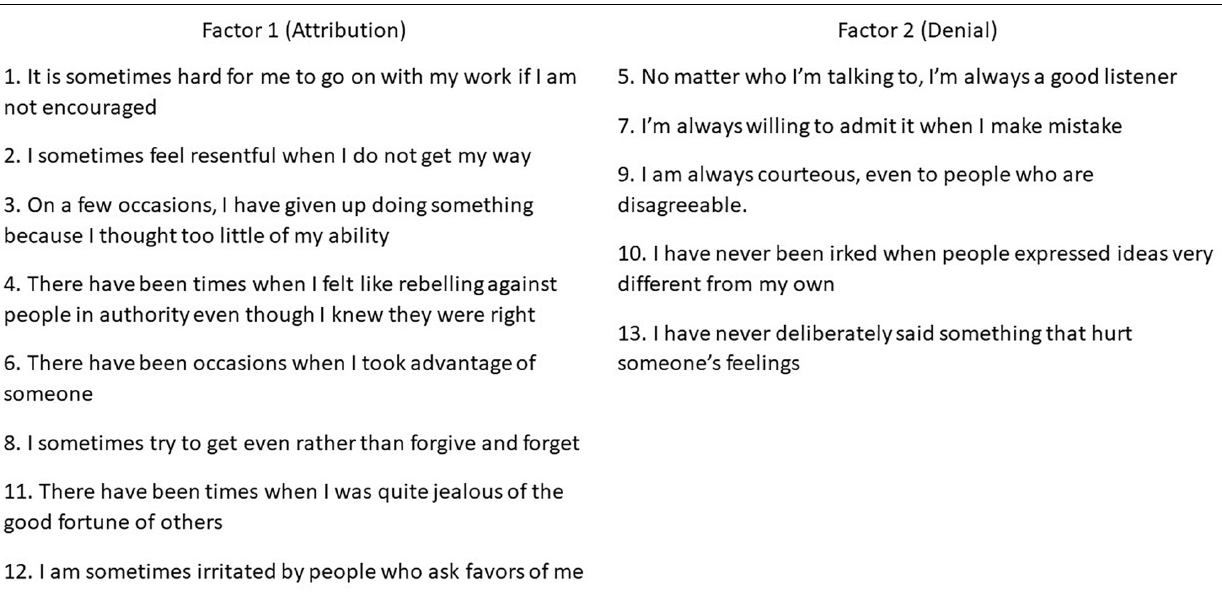
FIGURE 5 | Distribution of items across the two latent factors in the Kazakhstani MCSDS – Form